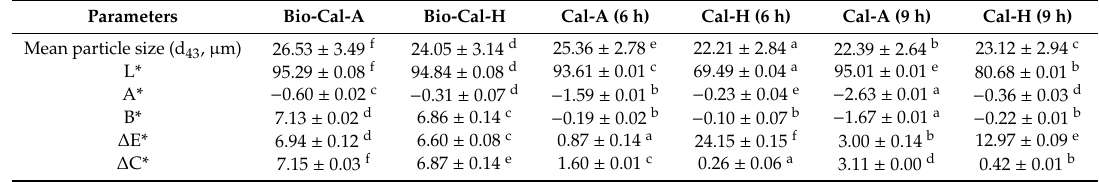
Table 2. Mean particle size and color values of bio-calcium and calcined powders from salmon frame.